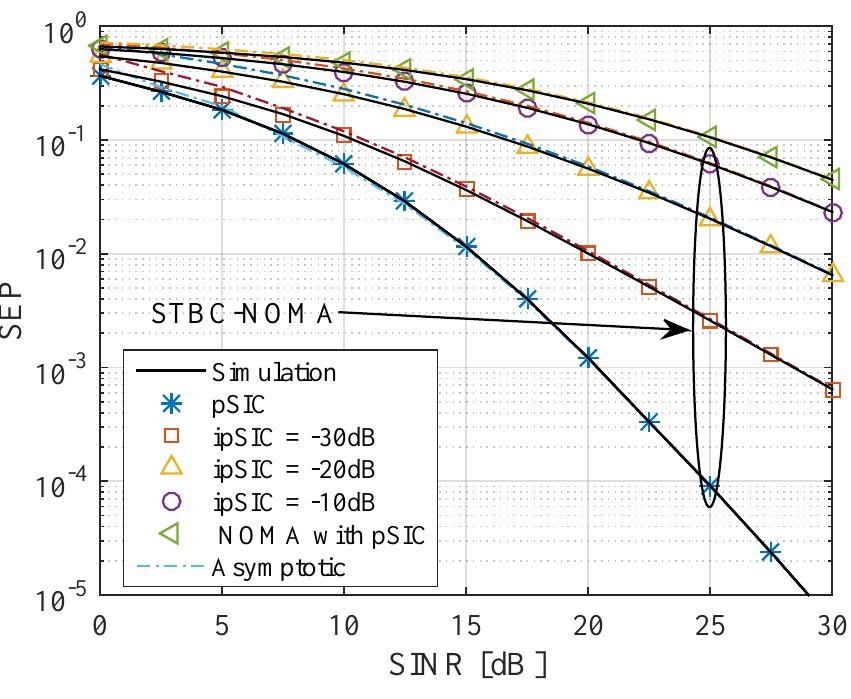
Figure 4. Symbol error probability of STBC-NOMA with U = 4 for imperfect SIC and perfect timing